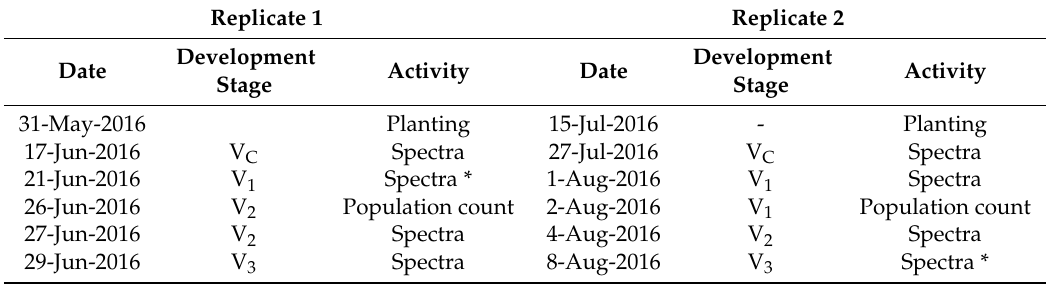
Table 1. Key dates for agronomical activities and spectral data